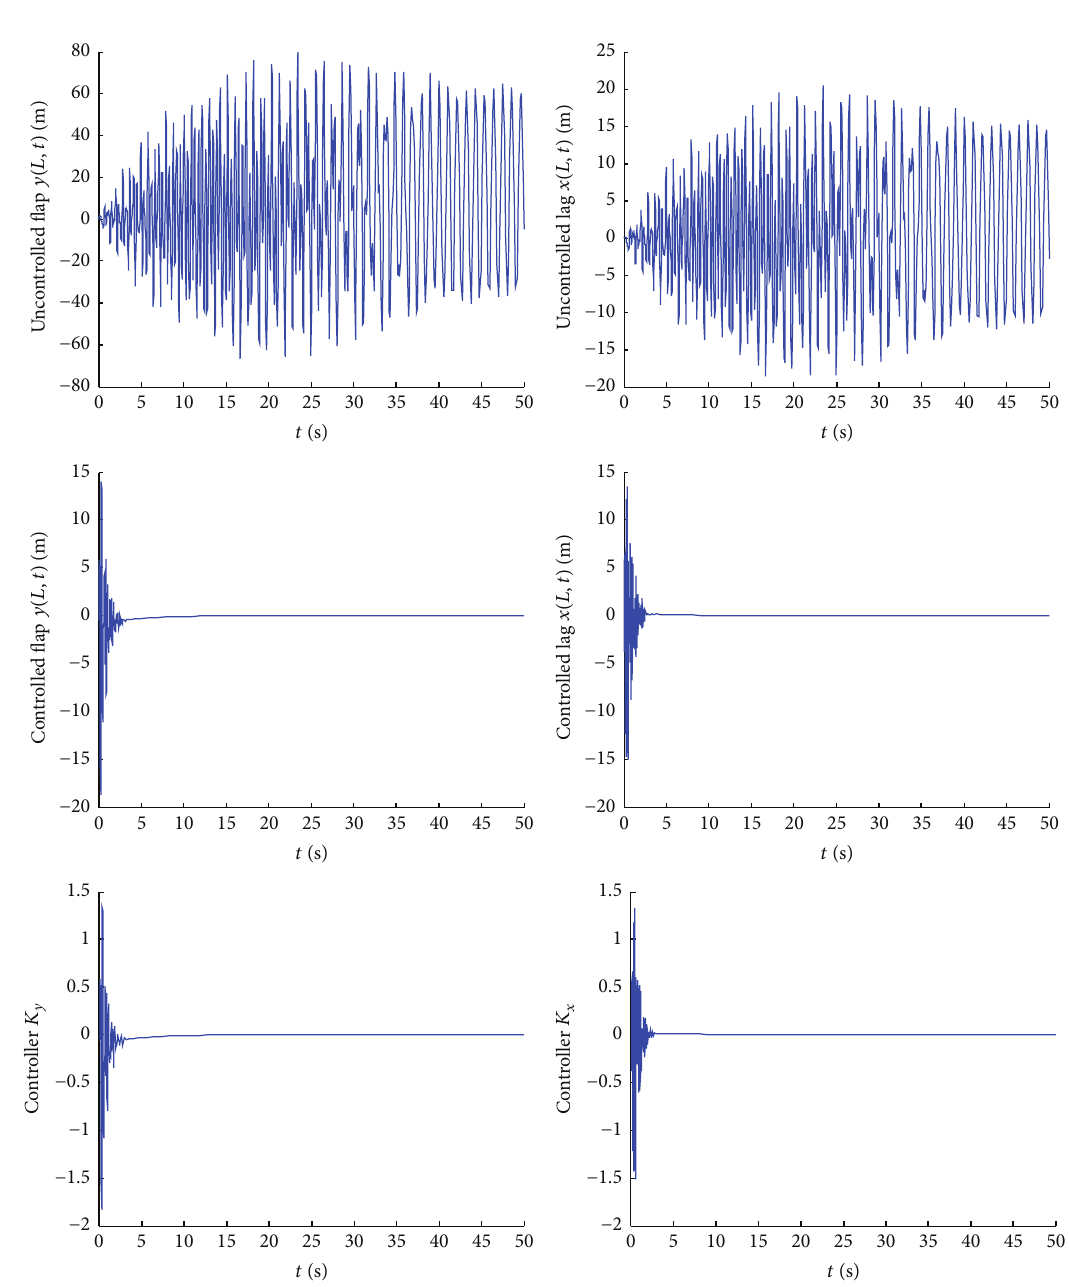
5.2. Bounded Phase Plane Study. For the time-varying